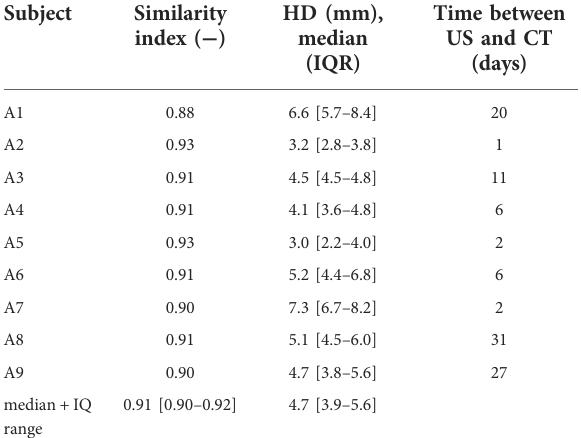
TABLE 2 Similarity indices and median hausdorff distances with interquartile range (IQR) of AAA geometries assessed from freehand 2D US data that were registered and compared to CT